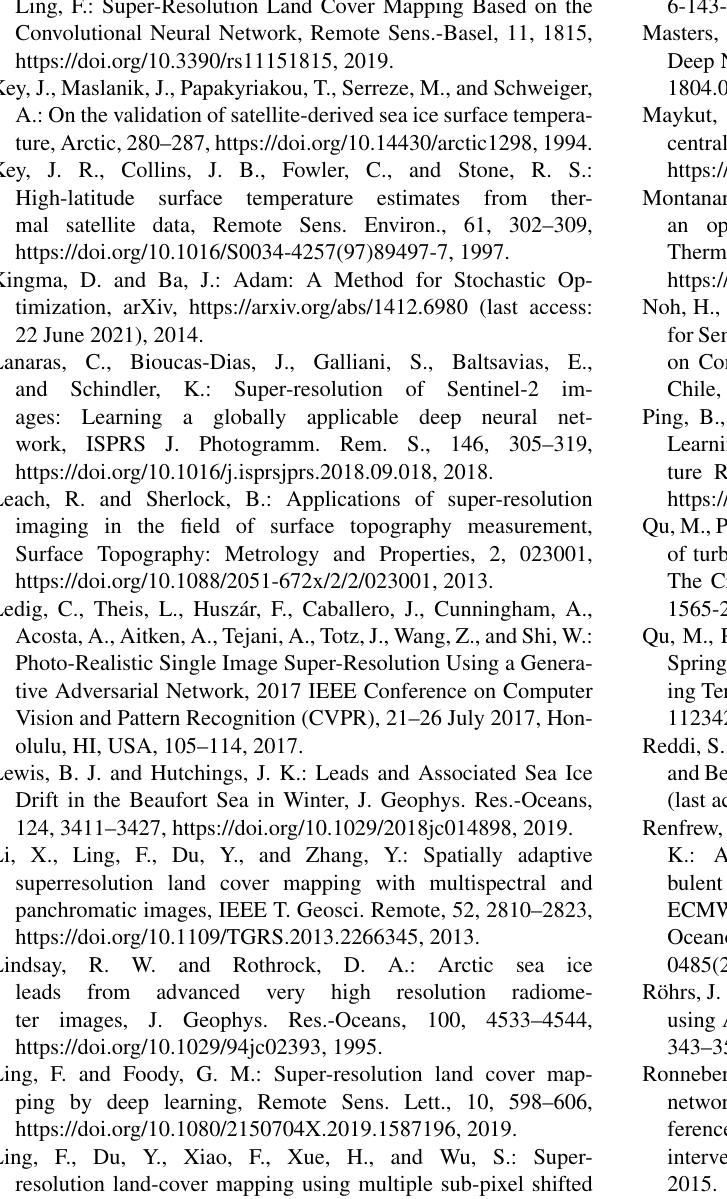
Algorithm Theoretical Basis Document (ATBD) for the MODIS Snow and Sea Ice-Mapping Algorithms, NASA GSFC: Green- gov/?c=atbd (last access: 22 June 2021),